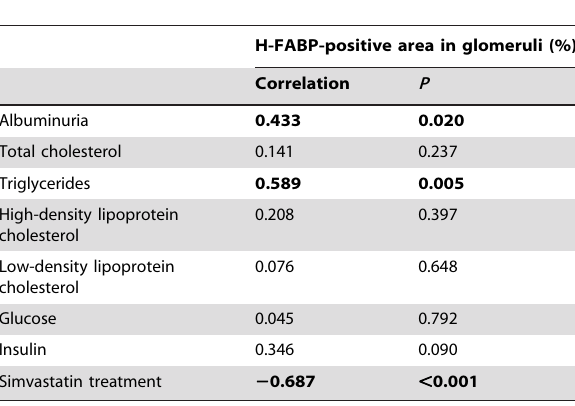
Table 3. The correlation of H-FABP expression with renal damage and metabolic disturbance in db/db